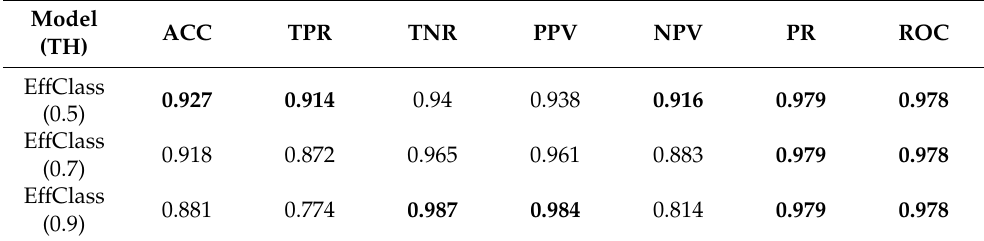
Table 1. Results per model and threshold ( TH ). Higher metrics values remarked on. EffClass : Efficient Classification, ACC: Accuracy, TPR: Sensitivity (Recall), TNR: Specificity, PPV: Positive Predictive Value (Precision), NPV: Negative Predictive Value, PR: Precision–Recall AUC, ROC: